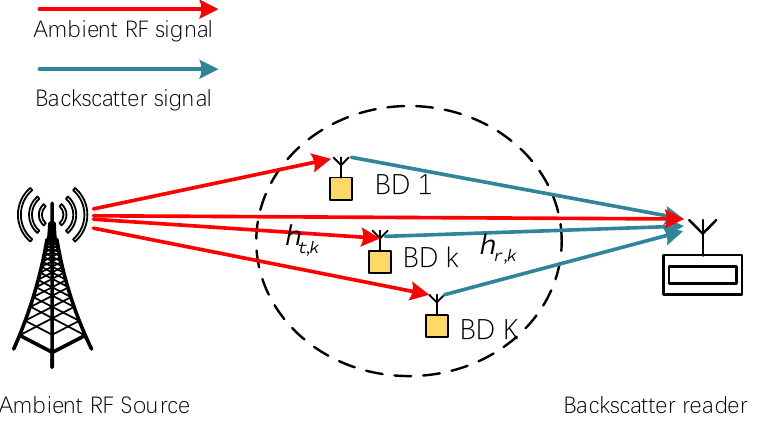
Figure 1. NOMA-assisted AmBC